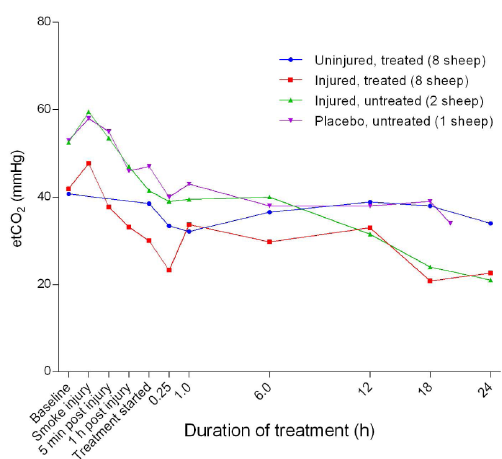
Figure 4. End-tidal carbon dioxide tension (etCO SD) in smoke and non-smoke injured sheep that received extracorporeal life support as compared to that in untreated controls.